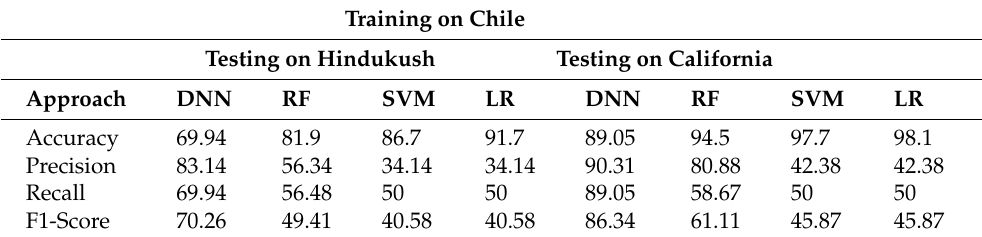
Table 5. Training on Chile, and testing on Hindukush and California.